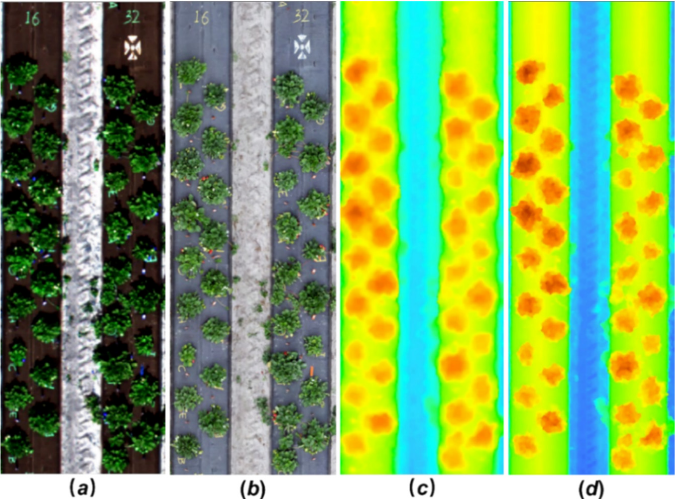
Figure 5. Comparison of ground-based imagery and UAV multispectral imagery: ( a ) UAV orthomosaic image with a spatial resolution of 1 cm; ( b ) ground-based orthomosaic image (1 mm); ( c ) UAV DSM product (1 cm); ( d ) ground-based DSM product (2 mm).